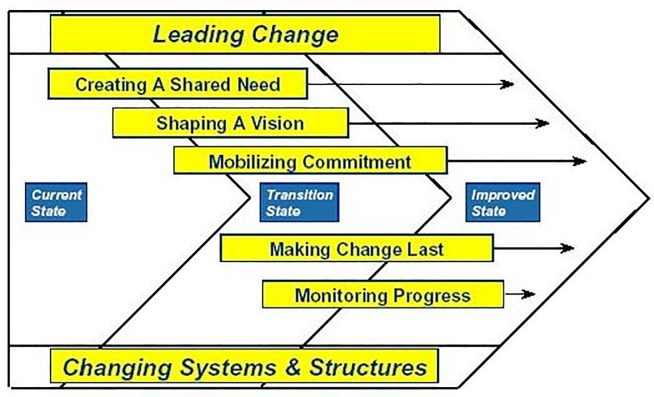
Change accelerated process [14].